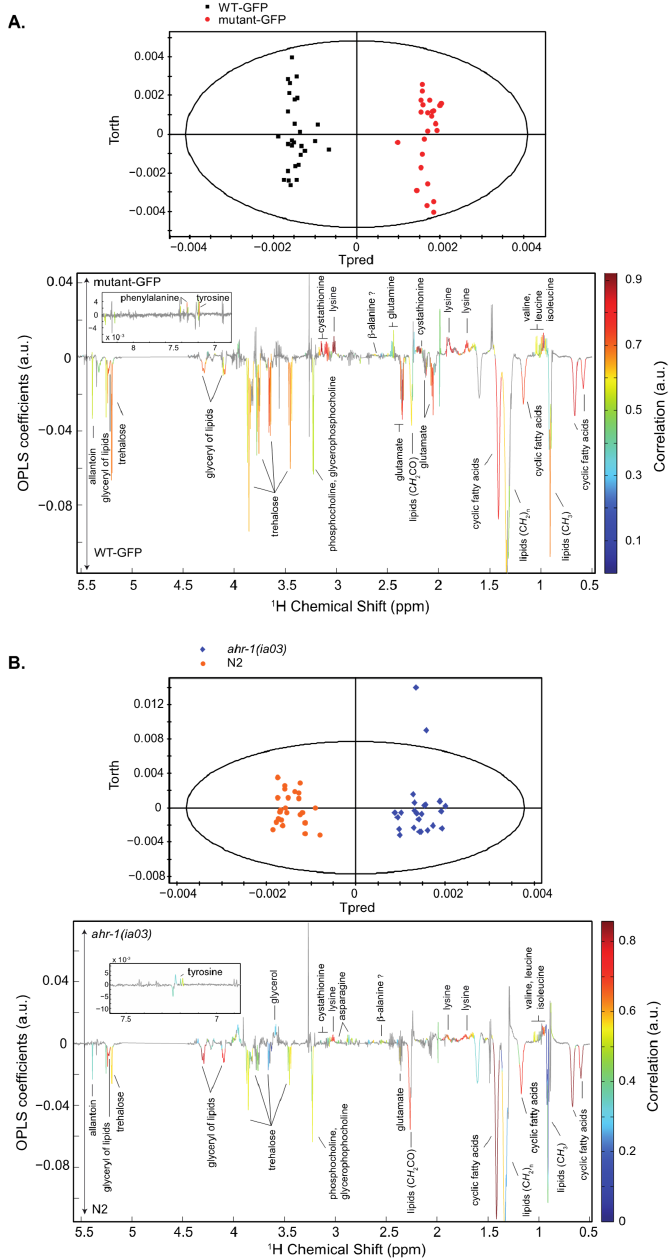
Figure 1. OPLS model discriminating WT ‐ GFP and mutant ‐ GFP ( A ) or N2 and ahr ‐ 1 ( ia03 ) ( B ). Top: Score plots. Bottom: Loading plots. ( A ) R2 = 0.783, Q2 = 0.973. mutant ‐ GFP is associated with high levels of phenylalanine, cystathionine, lysine, b ‐ alanine, glutamine, tyrosine, valine, leucine and iso ‐ leucine, and low levels of allantoin, trehalose, phosphocholine and glycerophosphocholine, gluta ‐ mate, cyclic fatty acids and glyceryl of lipids, by comparison to WT ‐ GFP. ( B ) R2 = 0.903, Q2 = 0.93. ahr ‐ 1 ( ia03 ) is associated with high levels of phenylalanine, glycerol, betaine, cystathionine, lysine, asparagine, tyrosine, valine, leucine and isoleucine, and low levels of allantoin, trehalose, glycer ‐ ophosphocholine, phosphocholine, cyclic fatty acids and glyceryl of lipids, by comparison to N2.